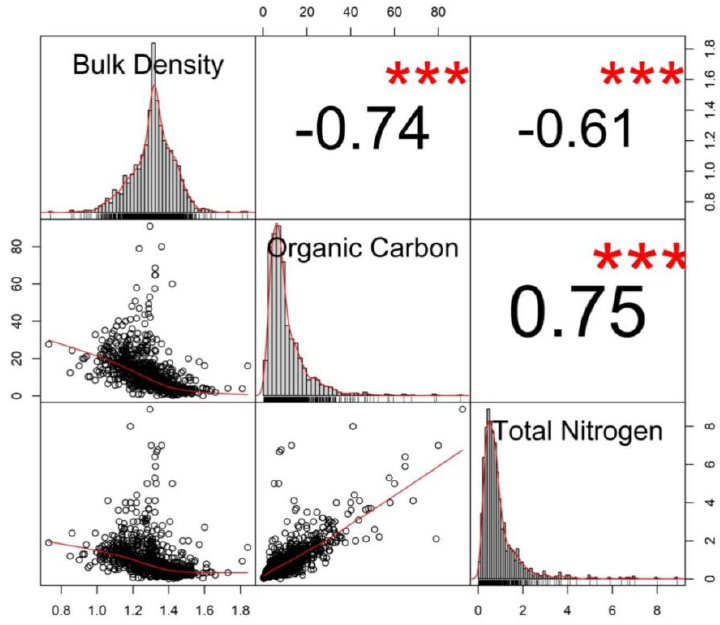
Figure 5. Improved scatterplot matrices of soil health indicators showing the histograms, kernel density overlays, absolute correlation, and significance levels (*** p < 0.001) of correlations between bulk density, organic carbon, and total nitrogen (after data imputation) .